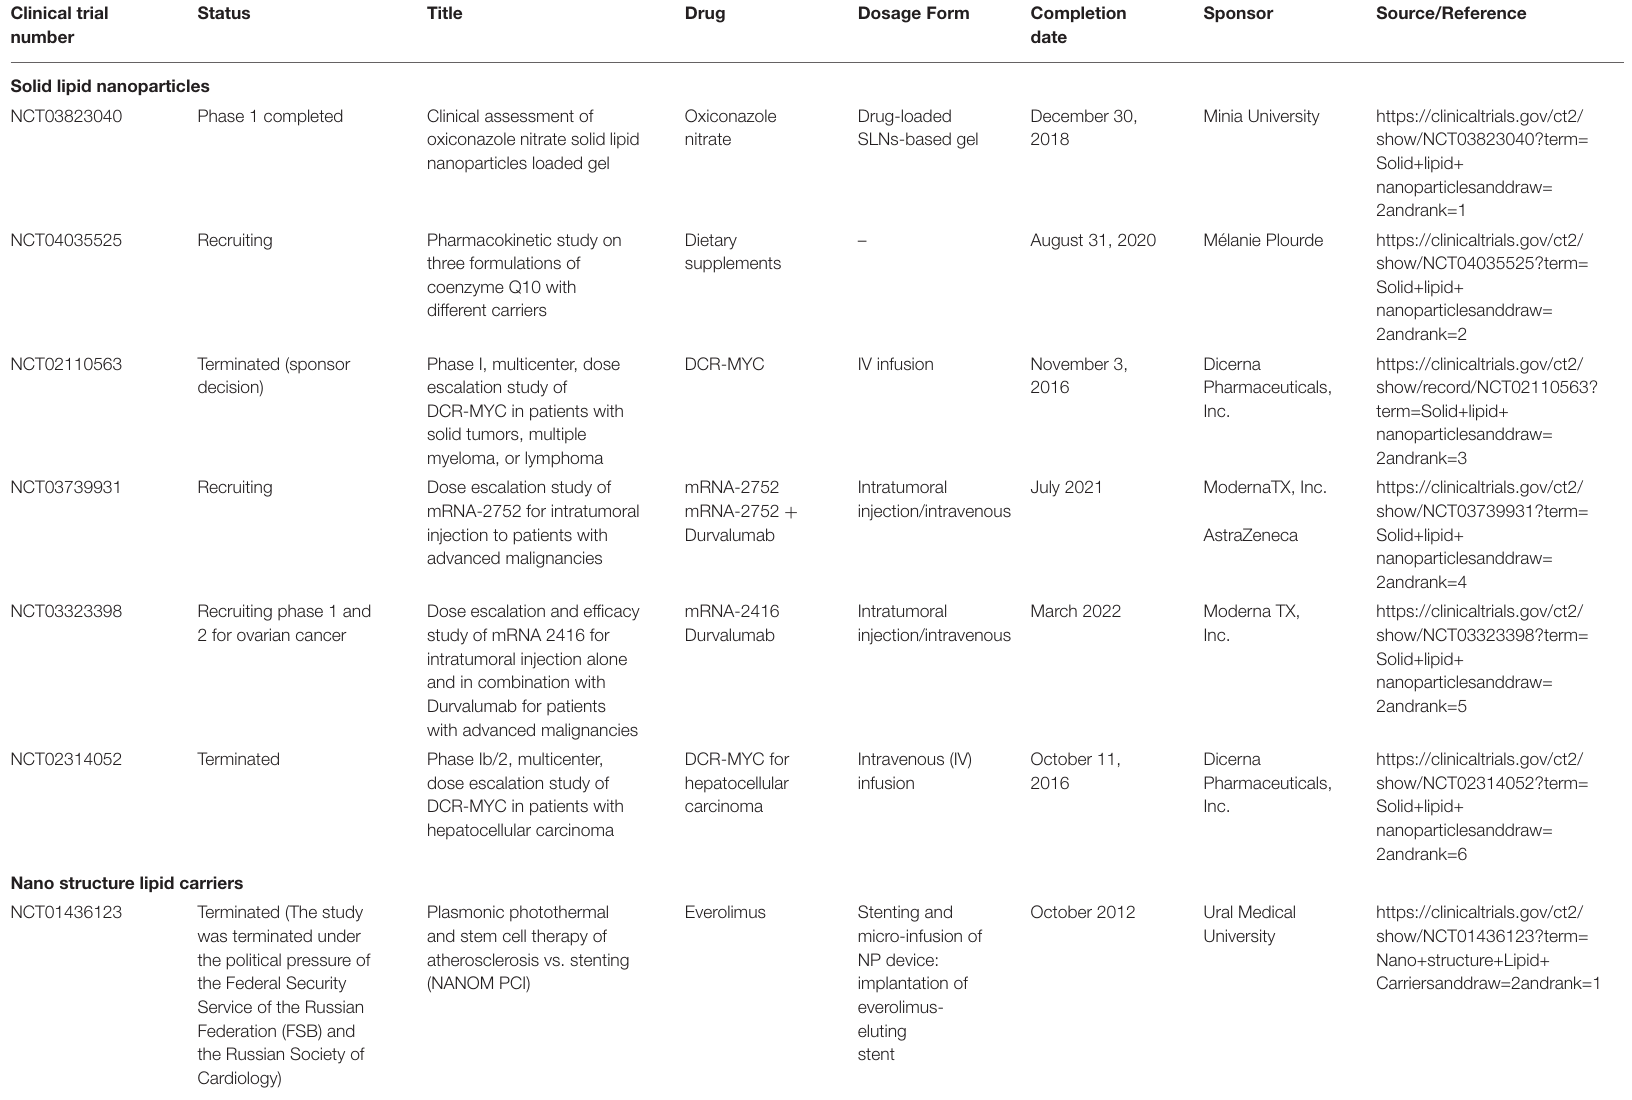
TABLE 4 | SLNs and NLCs in clinical